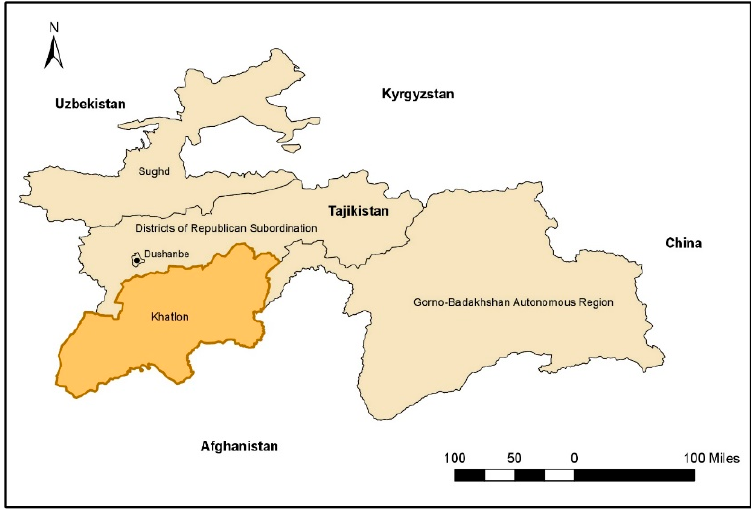
Figure 1. Provinces of Tajikistan.